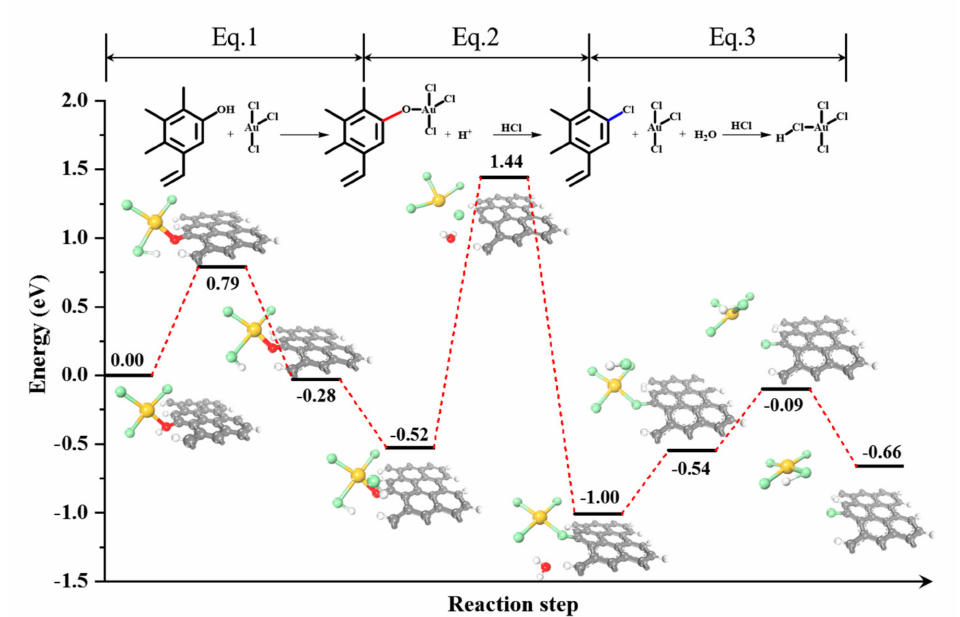
Figure 2. Reaction energy profile for proposed Au migration process. The green, gray, red, white, and yellow balls represent Cl, C, O, H, and Au atoms,